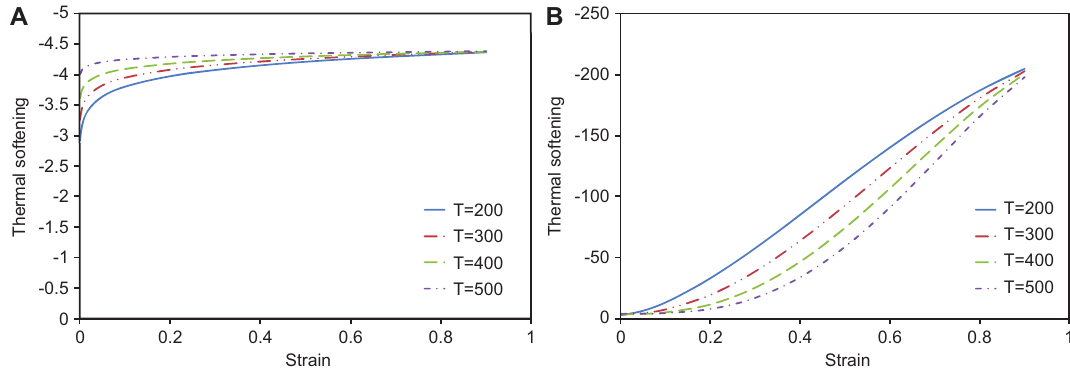
Figure 11 Thermal softening using (A) Eq. (10) and (B) Eq.